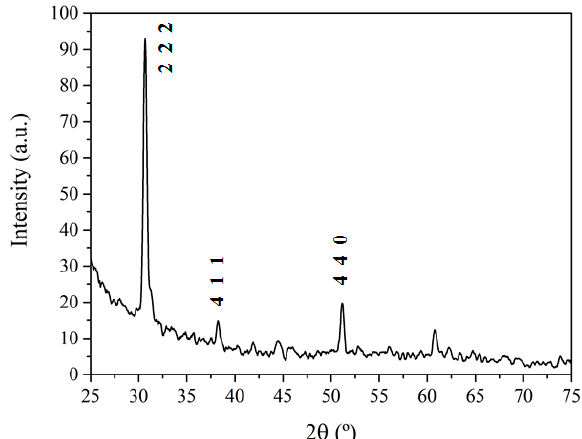
Figure 7. Measured XRD spectrum of (Ga x In 1-x ) 2 O 3 NWs from Sample A. The peaks are labelled assuming a cubic phase close to the In 2 O 3 known